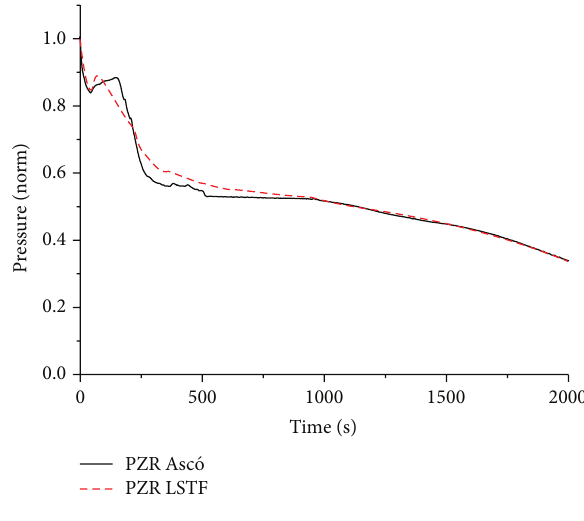
Figure 2: Primary pressure (picture from